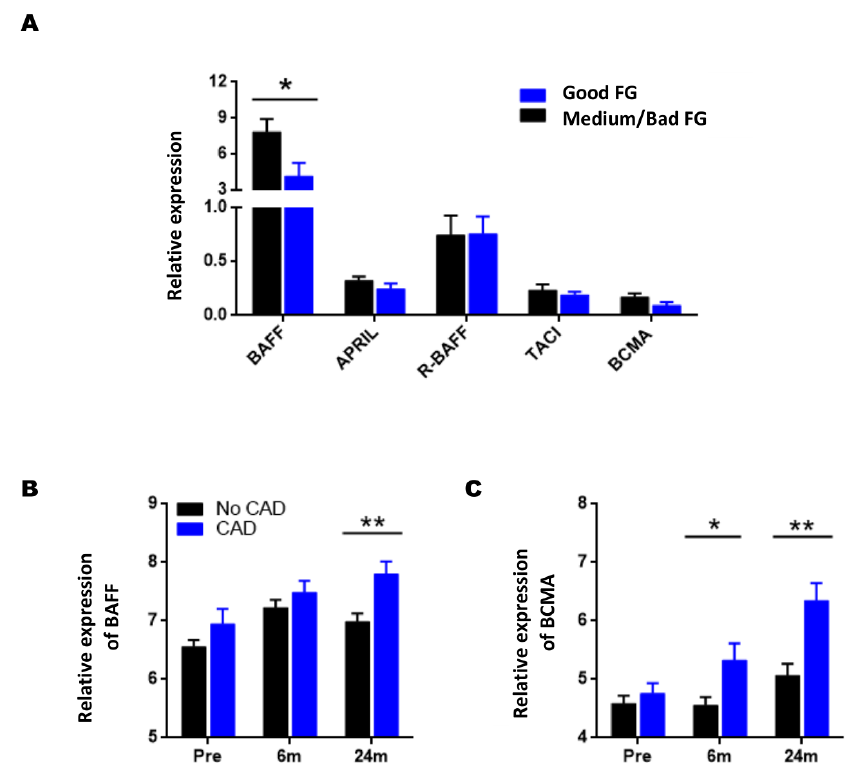
Figure 4. Association of post-transplantation kidney graft function and BAFF system gene expression levels at pre-transplantation ( A ) and BAFF and BCMA Gene Expression in Chronic Graft Damage Study GSE25902. Good GF with 94 and Medium/Bad FG with 26 patients ( B , C ). Data are represented as the mean ± SEM. Statistical analyses were performed using the Mann–Whitney U test to compare post-transplant groups. Comparison of the expression levels of BAFF ( B ) and BCMA ( C ) between the groups with chronic graft damage (CAD, blue bars) with 24 patients and those without CAD with 96 patients (black bars) at pre- and 6- and 24-months post-transplantation. Values p < 0.05 were considered significant. * p < 0.05; ** p < 0.01.